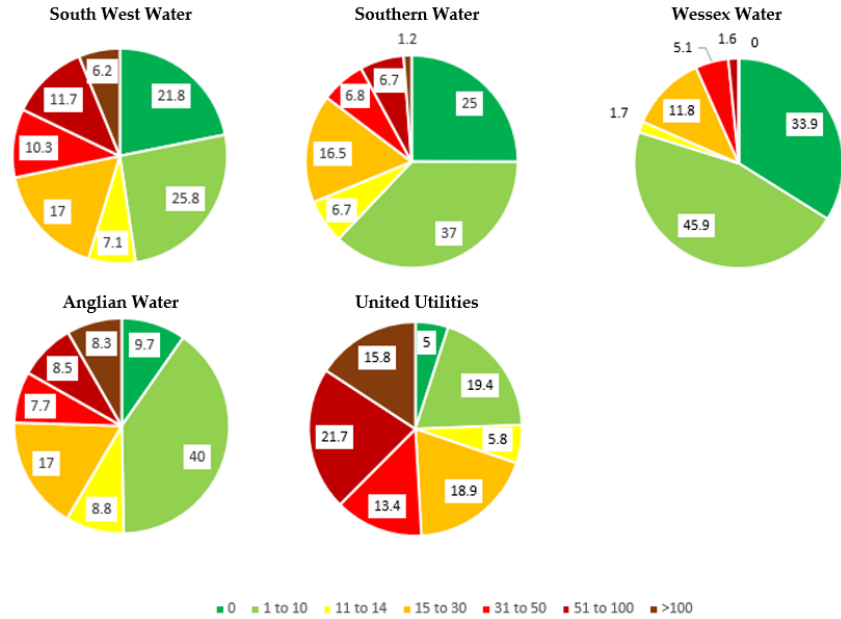
Figure 3. Storm overflow spill profiles for South West Water, Southern Water, Wessex Water, Anglian Water and United Utilities . Ranges are spill numbers, averaged for 2019 – 2021.